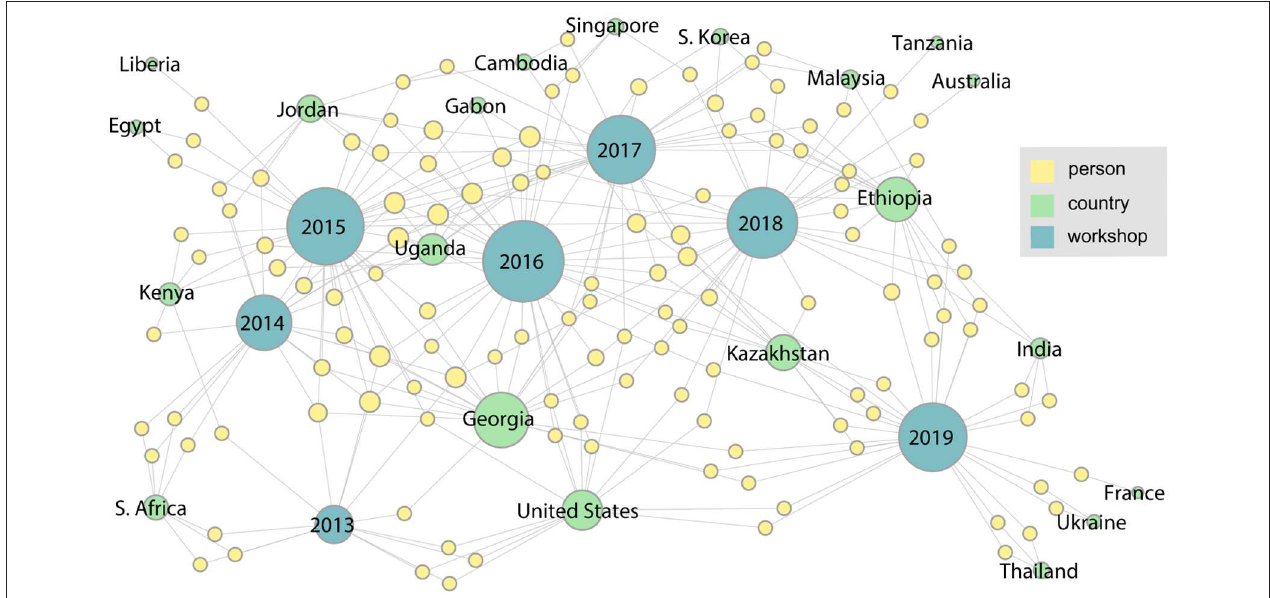
FIGURE 6 | The network for the entire series of workshops from 2013 through 2019.